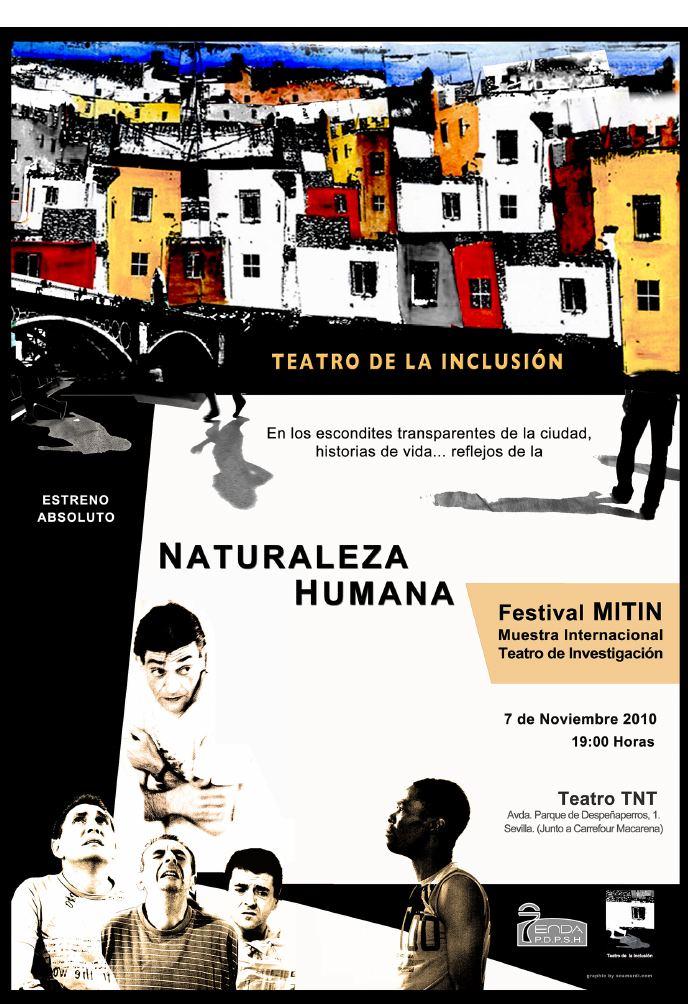
Figure 2. A poster announcing the premiere of Naturaleza Humana at the International Festival of Research Theatre in